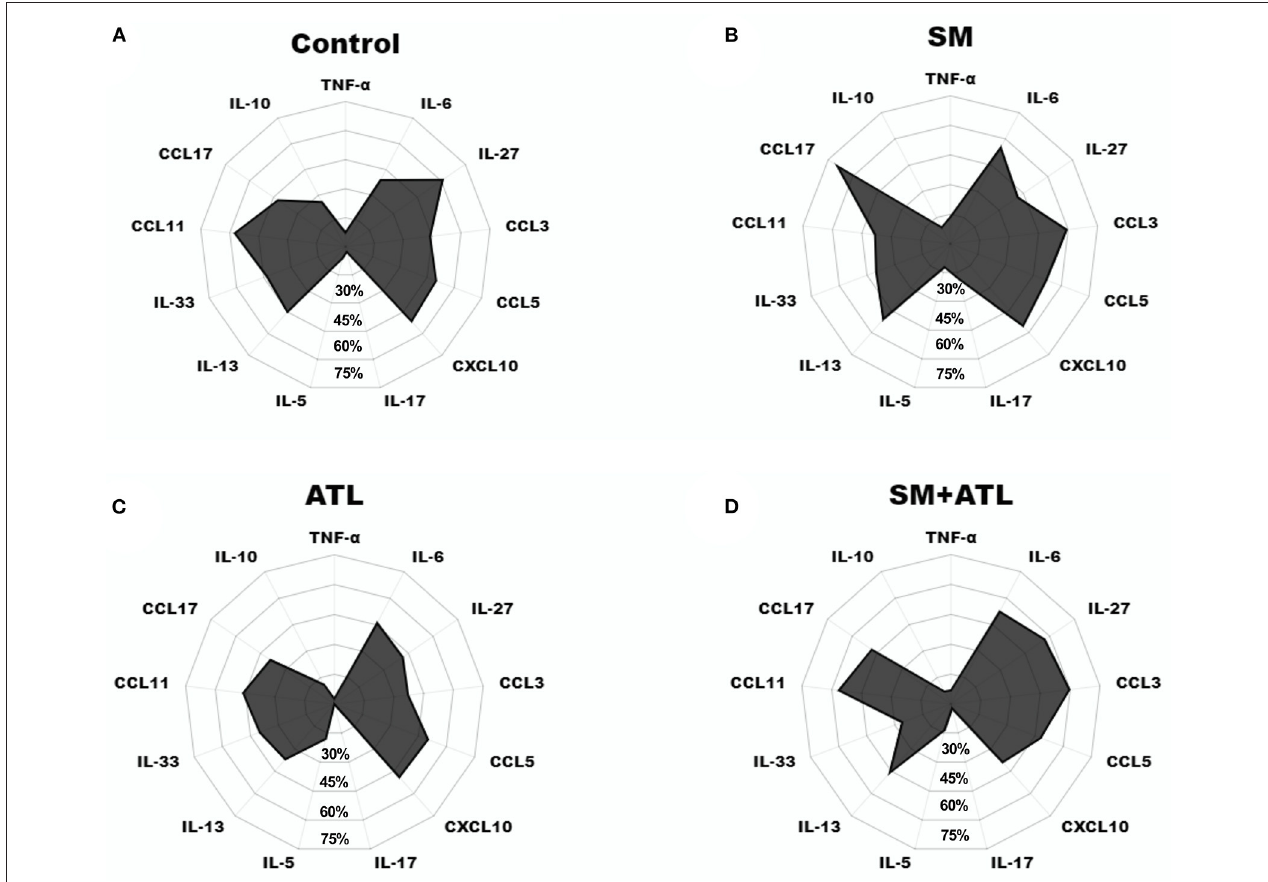
FIGURE 3 | Radar graph showing the frequency of serum samples with detectable levels of TNF- α , IL-17, IL-5, IL-13, IL-33, and IL-10, or with high levels of IL-6, IL-27, CCL3, CCL5, CXCL10, CCL11, CCL17 from individuals with different parasitic infection profiles living in the rural community of Brejo do Amparo, Januária, Minas Gerais, Brazil. (A) Control: no S. mansoni infection or ATL history; (B) SM, S. mansoni -infected only; (C) ATL, ATL history only; (D) SM + ATL, S. mansoni infection and ATL history.